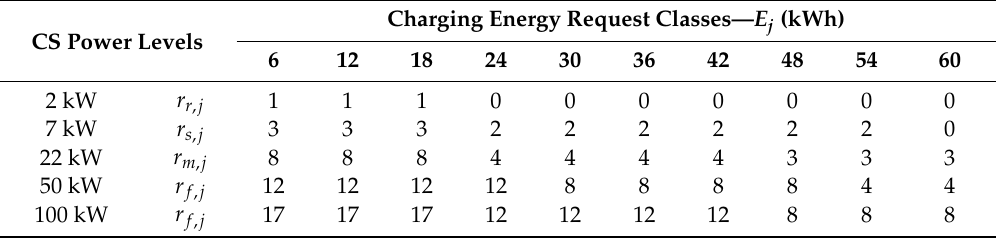
Table 10. Maximum number of charging events daily manageable by each level of energy requests, for each Charging energy request class.